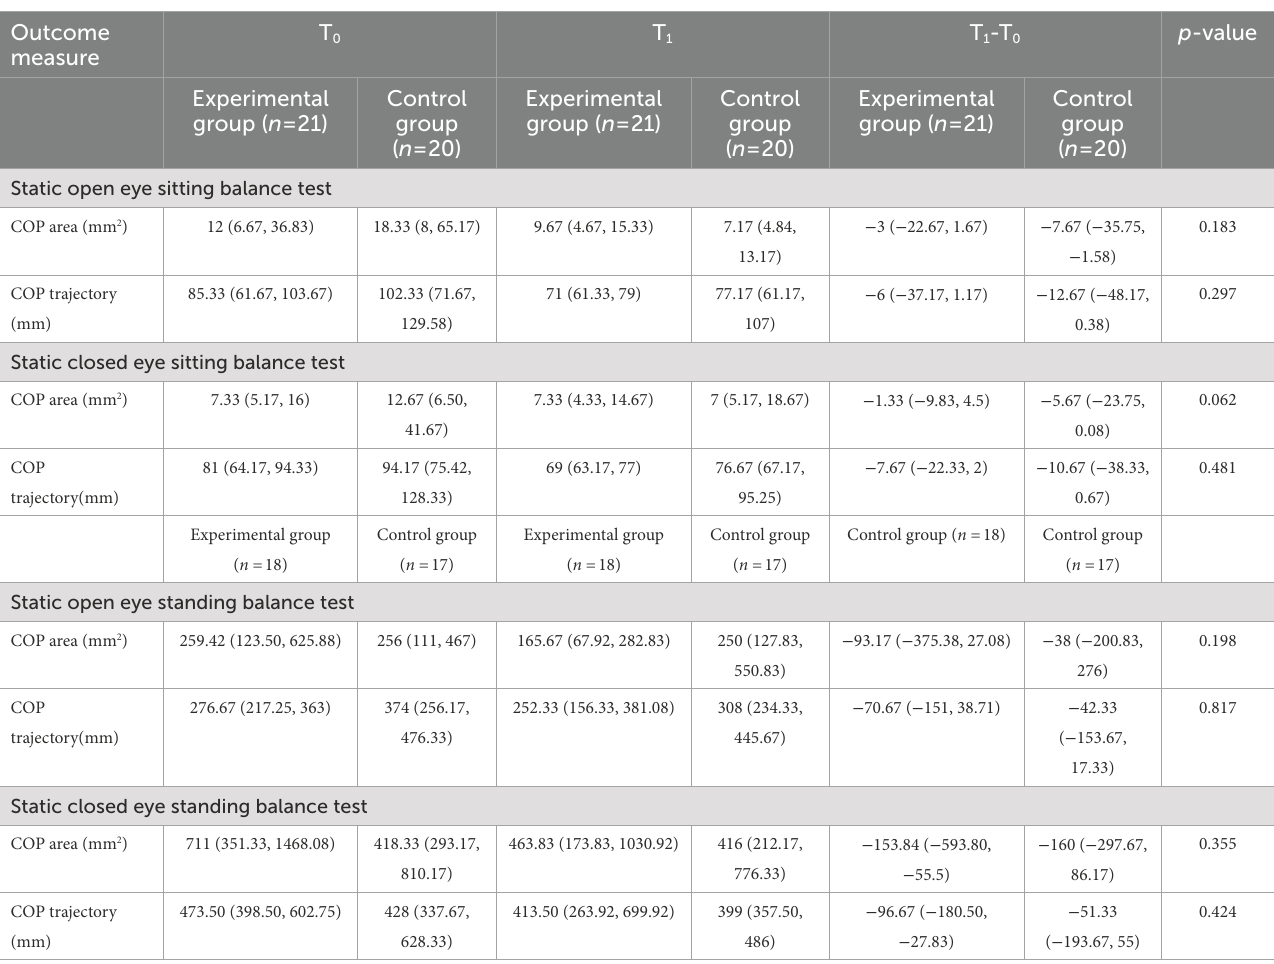
TABLE 3 Comparison of static balance ability.